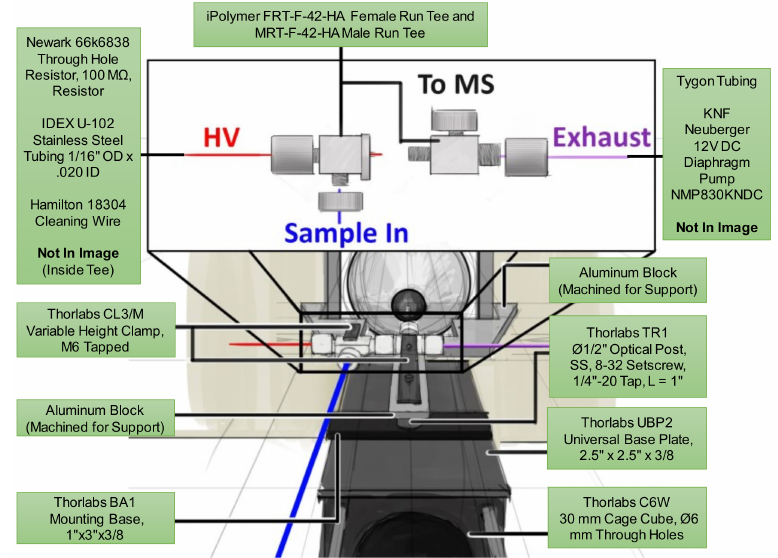
Figure 8. Simplified atmospheric pressure chemical ionization (APCI) source module built upon the ThorLabs cage cube for the centralized mounting system. A PTFE chamber is used to house a corona discharge needle and position it in proximity to the MS inlet capillary. The discharge needle is soldered to a stainless steel capillary for rigidity. High voltage is applied to the exposed portion of the discharge needle through an alligator clip electrode; a 100 M Ω resistor is soldered in series with the high voltage cable to produce a more effective corona discharge between the discharge needle and inlet